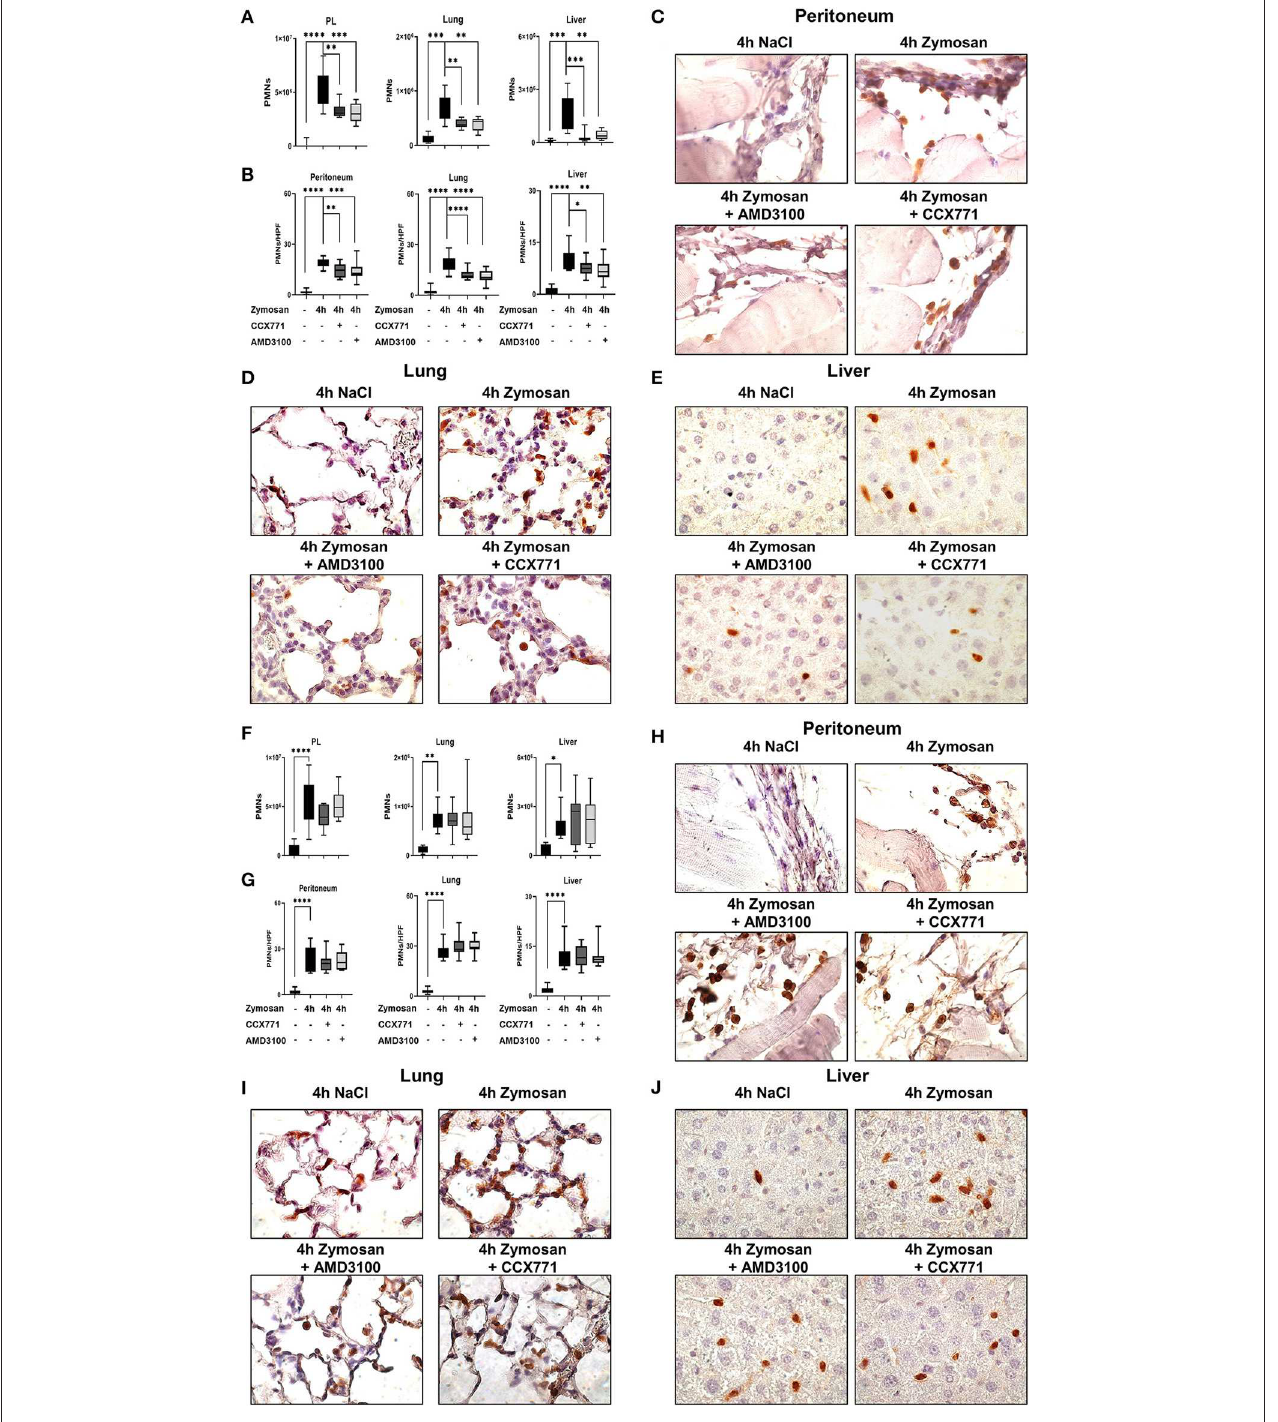
FIGURE 2 | CXCR4 and CXCR7 treatment dampens neutrophil migration into inflamed tissue through A 2B purinergic signaling. (A) We evaluated the influx of polymorphonuclear leukocytes (PMNs) into the peritoneal lavage, lung and liver tissue in wild type ( n = 8–12) and A 2B –/– animals (F) ( n = 6–12) with or without zymosan administration by flow cytometry. Animals were treated with AMD3100 (CXCR4-antagonist) or CCX771 (CXCR7-antagonist). PMN infiltration was also shown by immunohistochemistry, where PMNs were marked brown and counted per high power field (B,G) ( n = 16). Representative histological examination of the (C,H) peritoneum, (D,I) lung and (E,J) liver tissue in wild type and A 2B –/– animals are shown. Images are representatives of n = 3 experiments. For statistical analysis, one-way ANOVA was used with Bonferroni post-hoc test. Data are presented as box and whisker graph with error bars indicating the range from minimum to maximum value; * p < 0.05; ** p < 0.01; *** p < 0.001 and **** p < 0.0001.